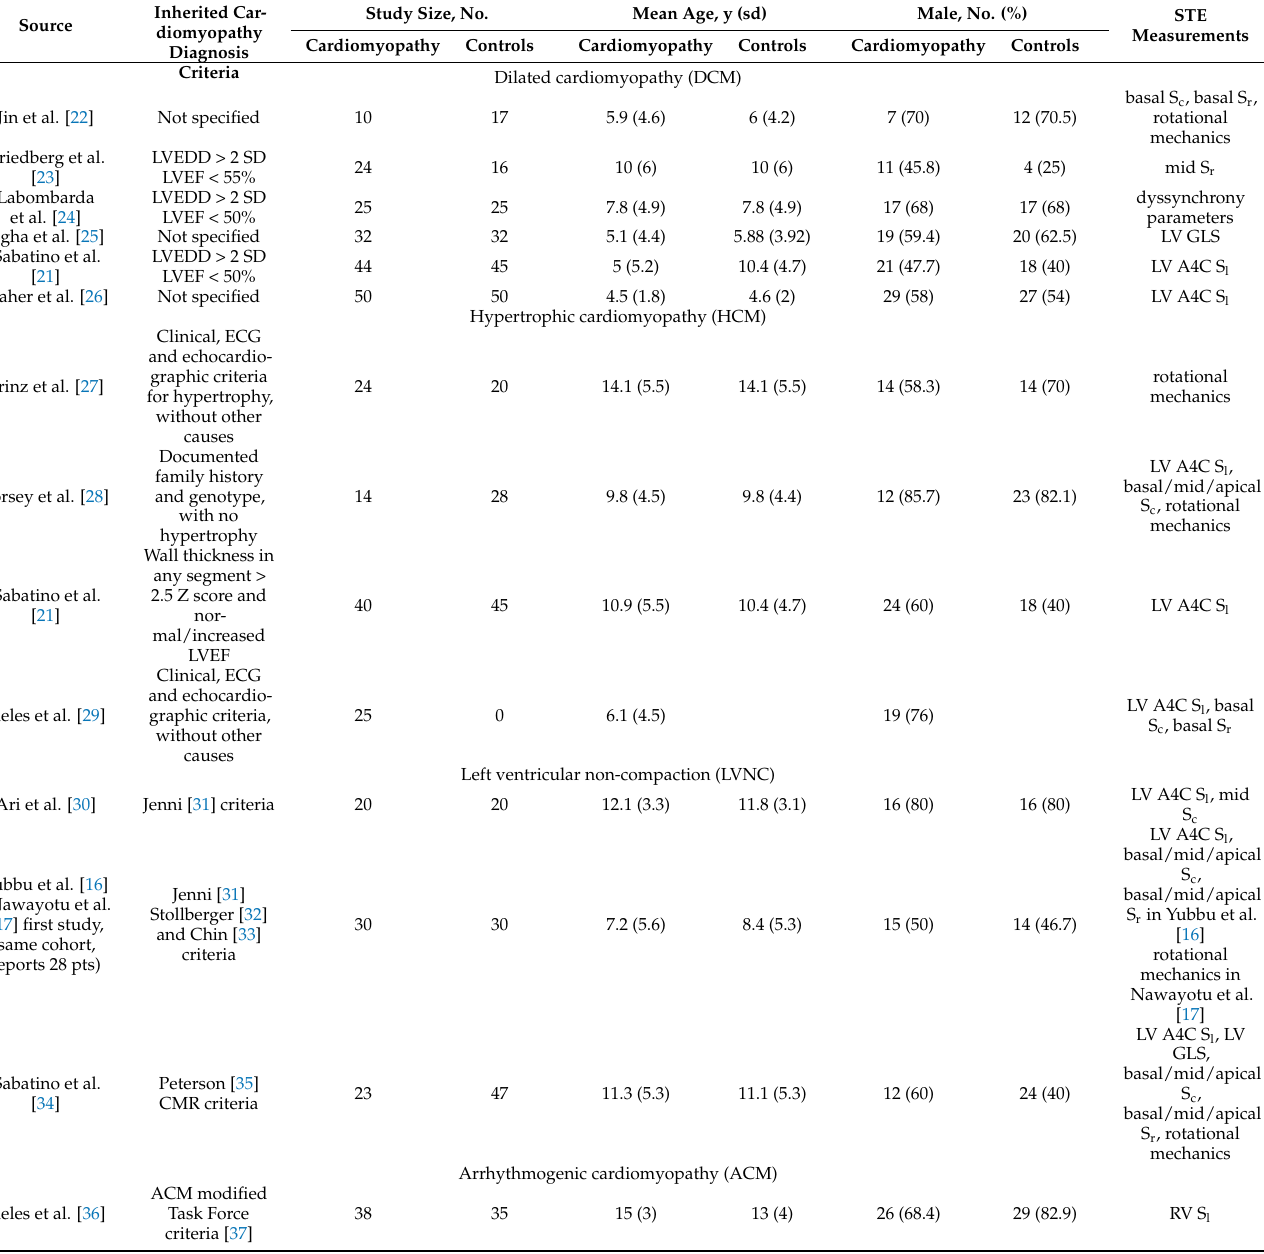
Table 1. Summary of included